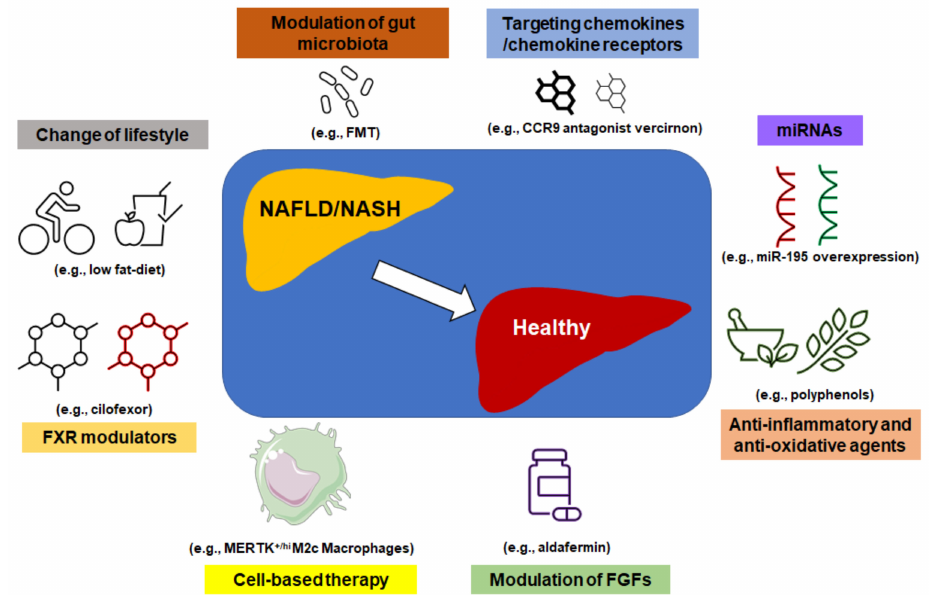
Figure 3. Treatment options for NAFLD. There are several options to accelerate the reverse of NAFLD even NASH, including modulation of gut microbiota, targeting chemokine/chemokine receptor signaling, change of lifestyle, modulation of miRNAs, Farnesoid X receptor (FXR), and fibroblast growth factors (FGFs), cell-based therapy, anti-inflammatory, and anti-oxidative agents, as well as